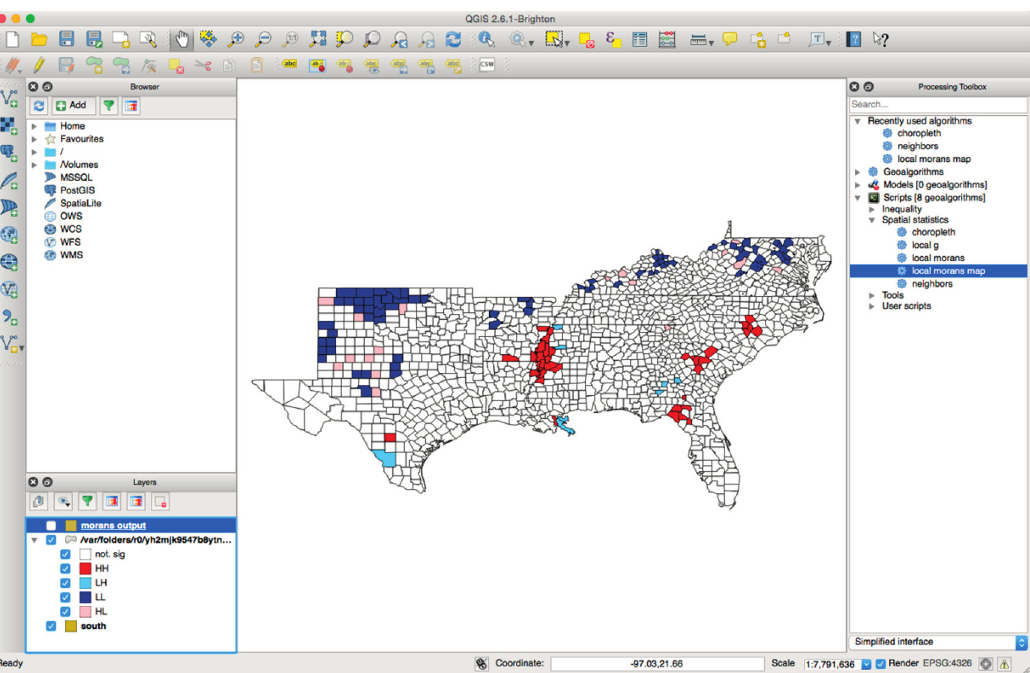
Figure 4. PySAL in the Processing Toolbox of